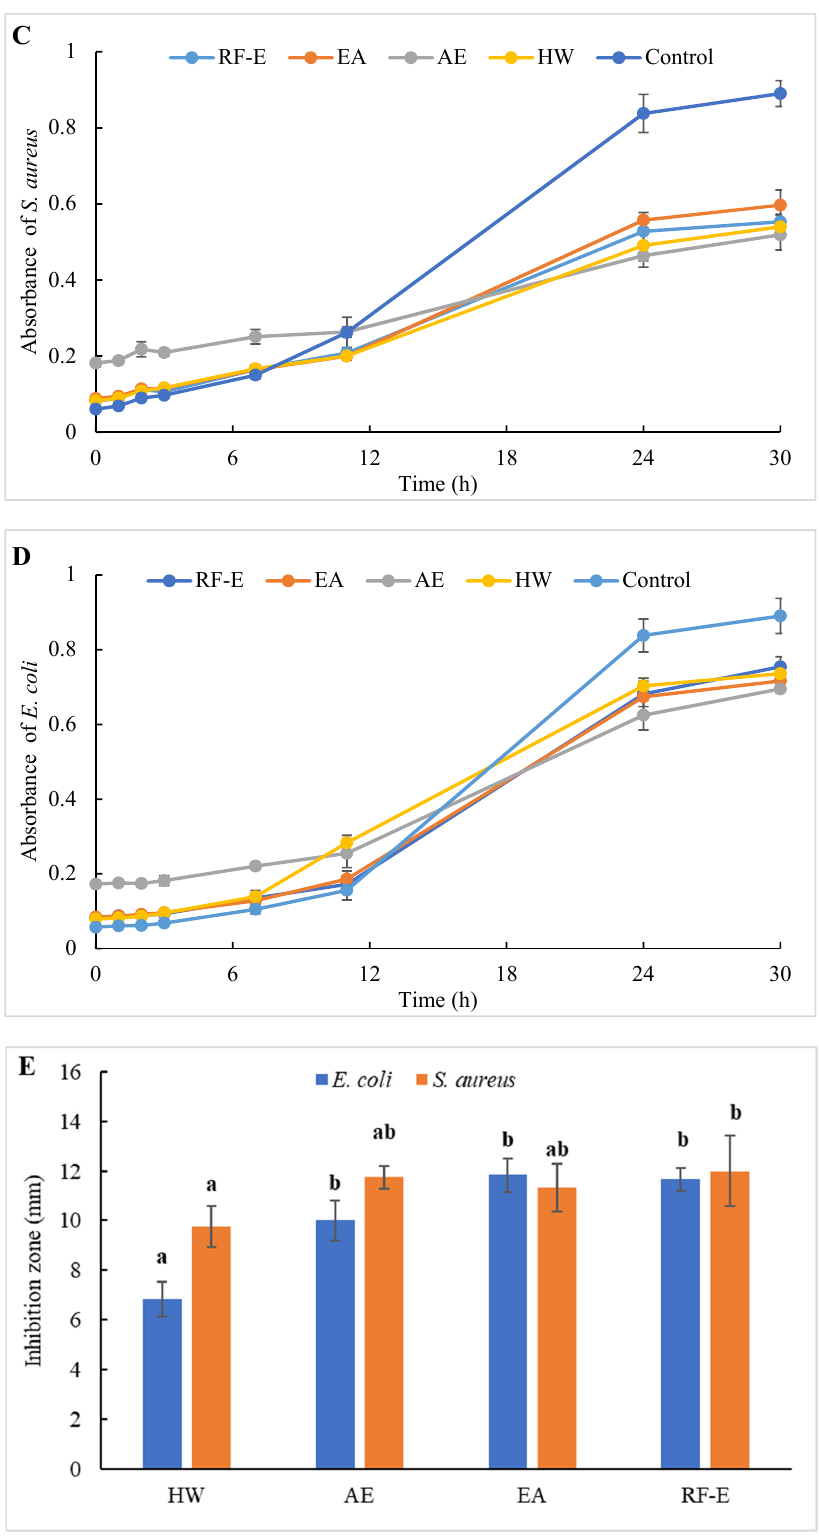
Figure 4. Antibacterial activities of A. trifoliata flower extracts. Different lowercase letters show significant differences at the p < 0.05 determined by Duncan’ s multiple range tests. See Figure 1 for abbreviations. S. aureus , Staphylococcus aureus ; E. coli , Escherichia coli